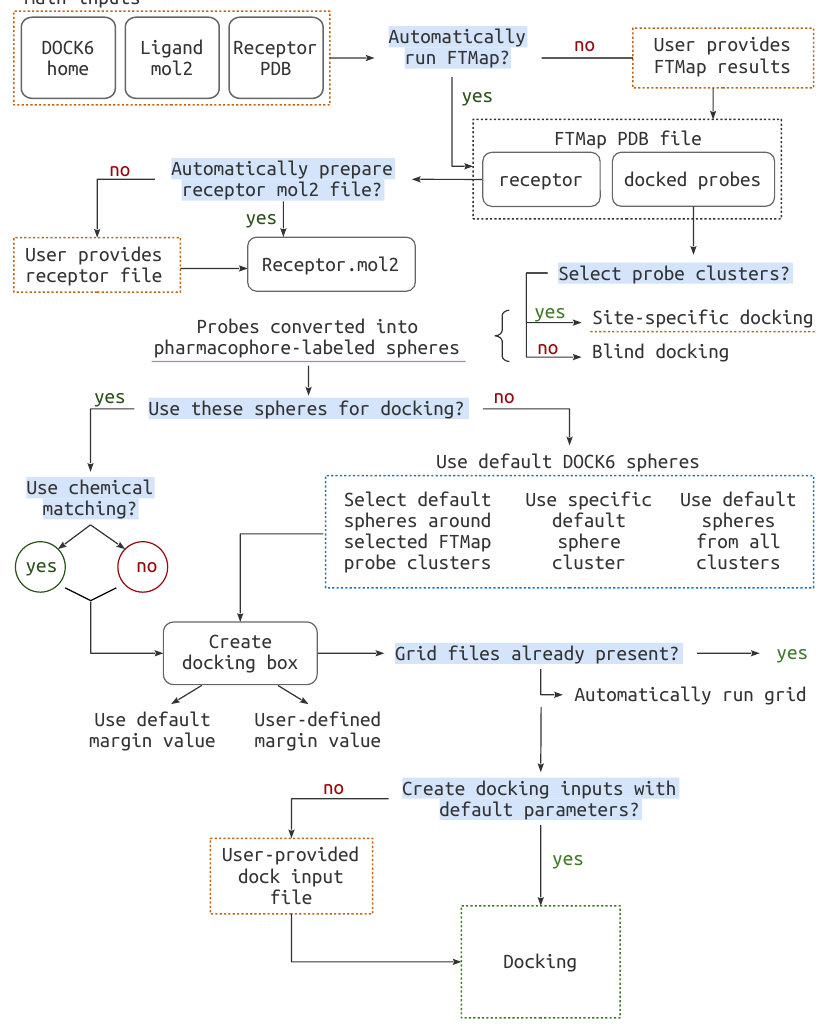
Figure 2. The complete workflow. for the BLinDPyPr program. Highlighted in blue are the decisions which must be made by the user. The files that may be provided to BLinDPyPr are marked with dashed orange